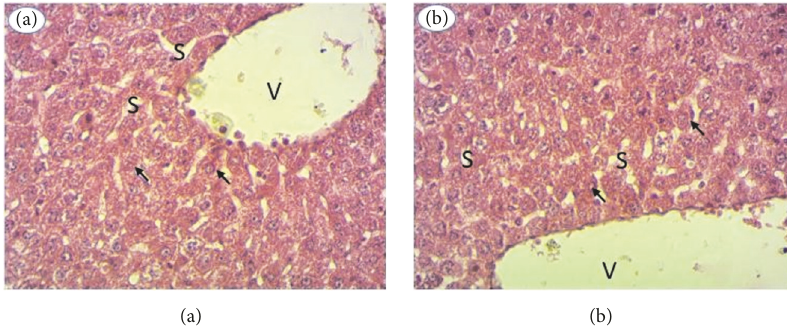
Figure 5: Liver histology, 400x magnification. (i) V: centrilobular vein. (ii) S: sinusoids.